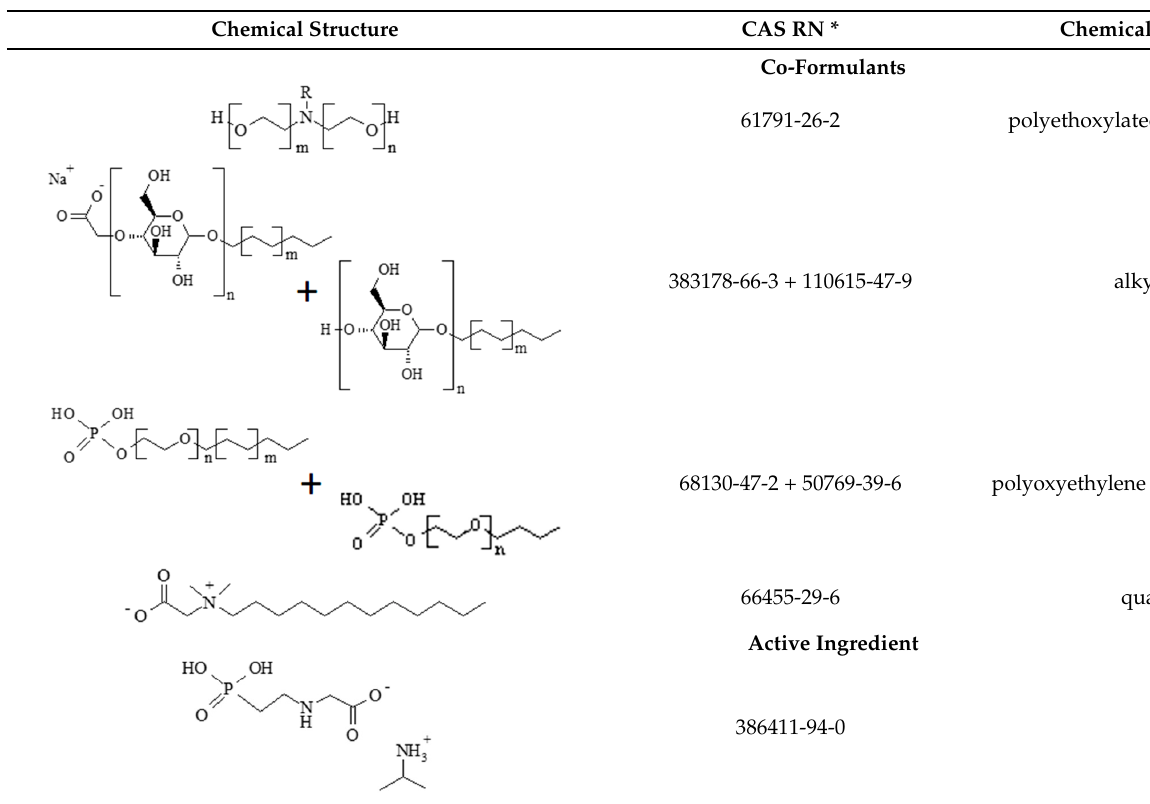
Table 2. Chemical structures of the co-formulants and declared active ingredient of glyphosate-based herbicides investigated in this study. CAS registry numbers are declared by the manufacturers or